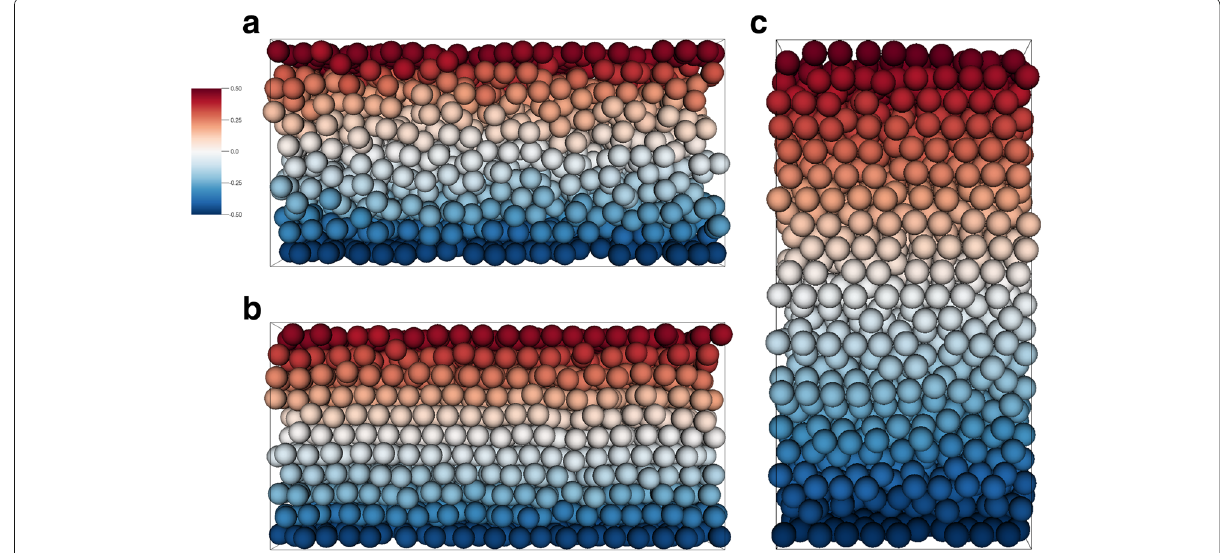
Fig. 5 Shearing of dense suspensions. Color bar indicates streamwise velocity of particles. Shown are instantaneous snapshots for a Re = 10 and = 0.42, b Re = 10 and φ = 0.54, and c Re = 40 and φ φ v v